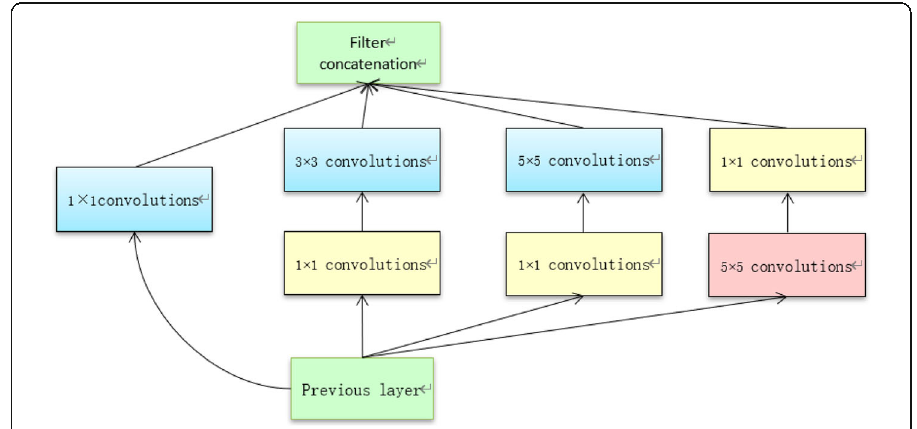
Fig. 3 The structure of the key modules of the Inception